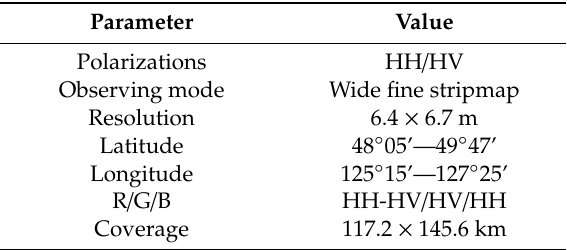
Table 5. Detailed parameter of the high-sea state data.